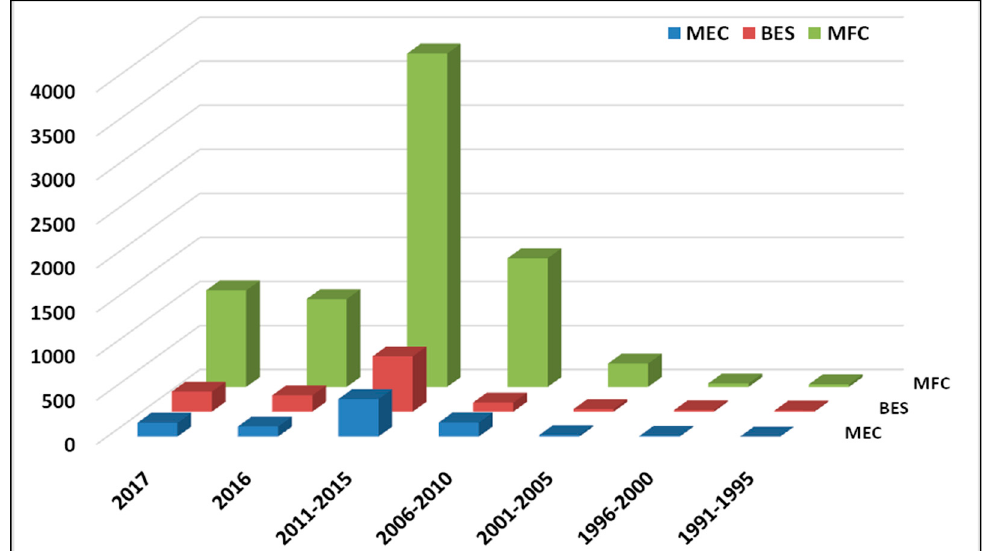
Figure 1. Number of research articles published on different variants of bio-electrochemical system since 1991 to 2017 (Scopus data, accessed on 12 January 2018). MEC: microbial electrolysis cell, BES: bioelectrochemical system, MFC: microbial fuel cell.